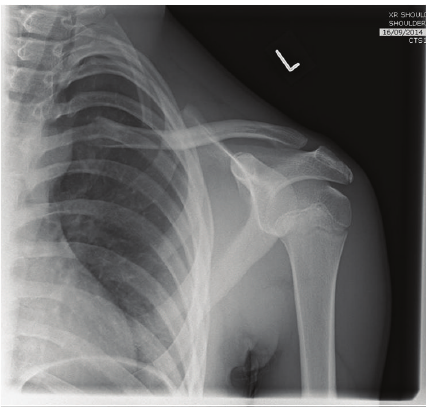
Figure 1: AP X-ray indicating minimally displaced mid-clavicle fracture.